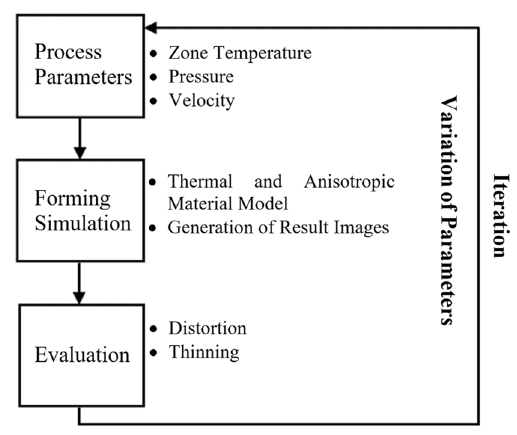
Fig. 3 Schematic representa- tion of the DoE study using the example of hot forming